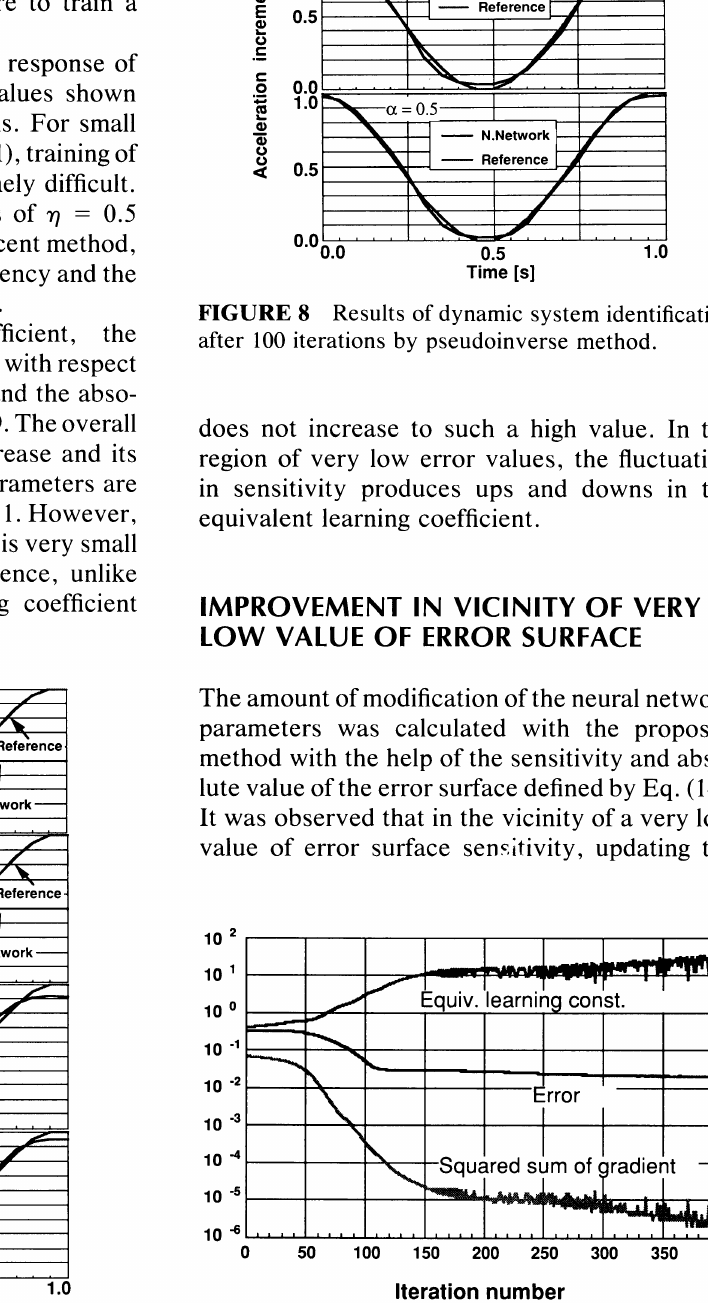
FIGURE 9 History of equivalent learning coefficient, error, and squared sum of gradients of linear single degree of freedom mass-spring